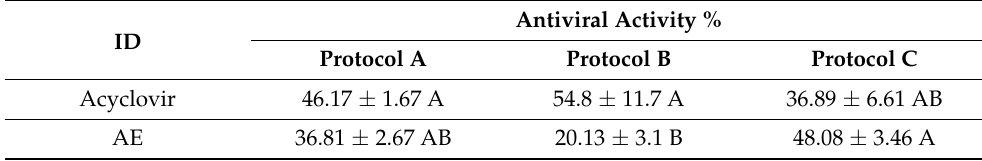
Table 6. Antiviral efficacy of the Annona extract versus HAV vs. acyclovir, and protocols in parameters of antiviral activity % values (M ±